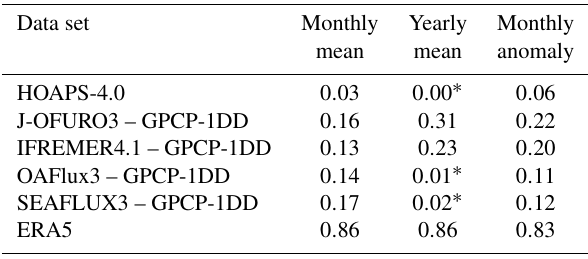
Table 3. Pearson’s correlation coefficient squared ( R 2 ) for monthly (mean or anomaly) or yearly global ocean mean E ocean −∇· (vq) vs. P ocean , with ∇ · (vq) data from ERA5. R 2 was calculated from data sets that were collocated prior to the calculation of global